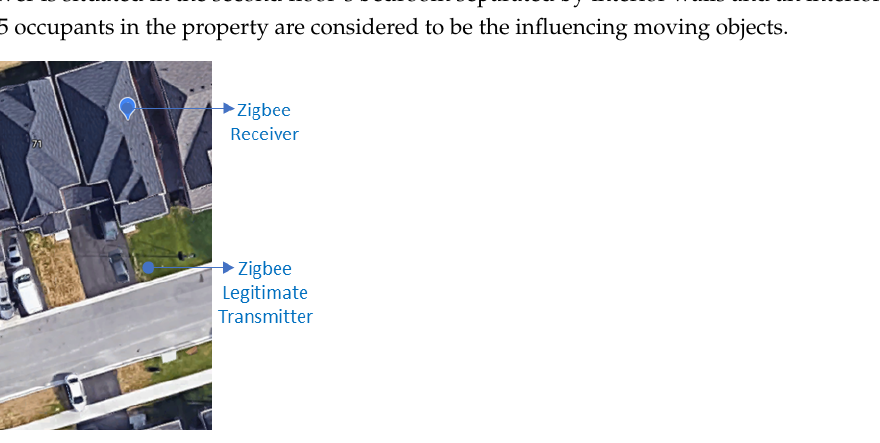
Figure 6. The legitimate transmitter is situated outdoors on the lawn transmitting temperature readings and the receiver is situated in the bedroom of the second floor separated by exterior building walls. The pedestrians and motor vehicles in the nearby residential area as well as the 5 occupants in the property are considered to be the influencing moving